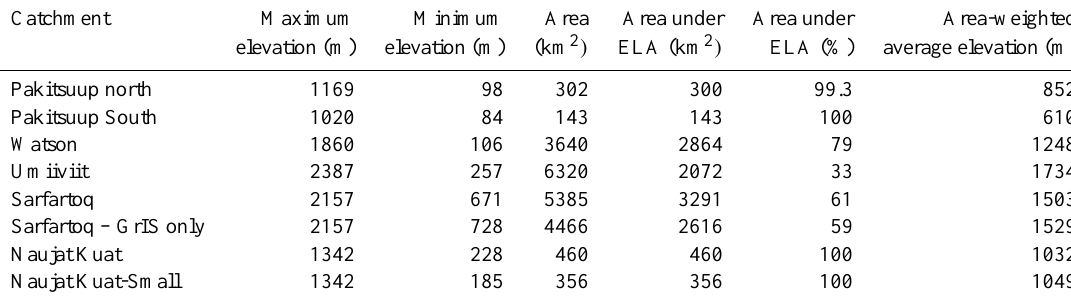
Table 1. Various measures of glacier catchments in paper. Catchment Maximum Minimum Area Area under Area under Area-weighted elevation (m) elevation (m) (km 2 ) ELA (km 2 ) ELA (%) average elevation (m) Pakitsuup north 1169 302